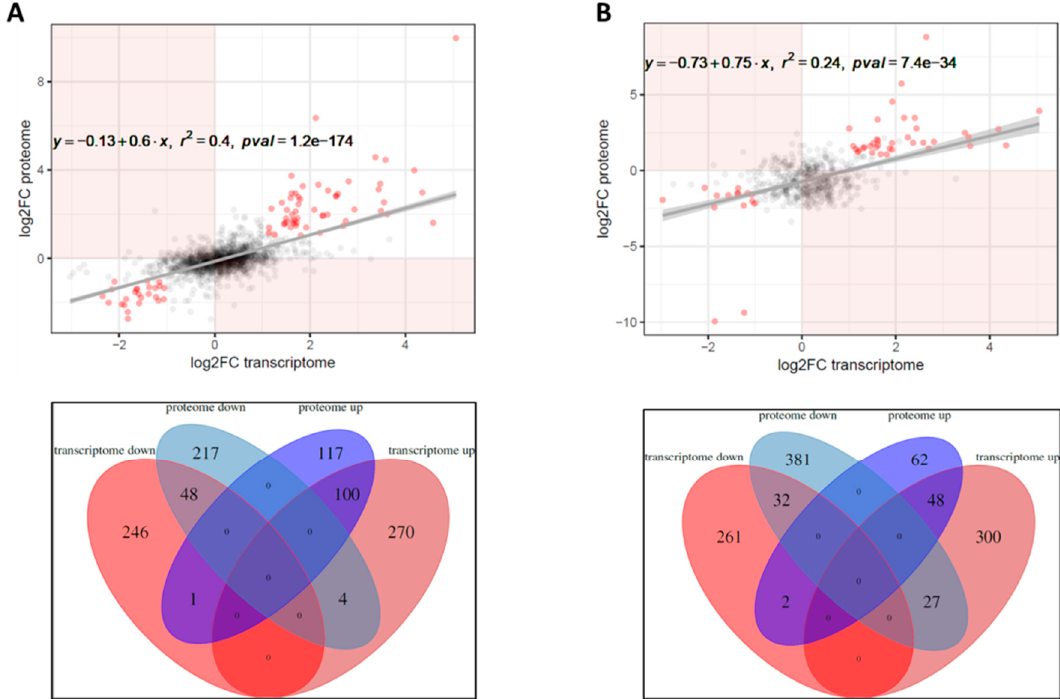
Figure 6. Correlation analysis between transcriptomic and proteomic datasets. ( A ) Scatterplots representing the pairwise comparisons of Δ hfq /wt log 2 ratios between transcriptome and either proteome (left) or secretome (right). Only the genes for which levels of corresponding proteins were reliably detected by label-free quantification were used for correlation analysis. Red dots depict genes which are significantly deregulated in both datasets ( p -value < 0.05, |log 2 FC| > 1). Line depicts the best fit as predicted by linear regression. ( B ) Venn diagrams showing the number of differentially expressed genes and proteins and the overlap between each dataset. Left: comparison of transcriptome and proteome. Right: comparison of transcriptome and secretome. Zero values indicate intersections which can not materialize (i.e., being up- and downregulated in the same dataset).